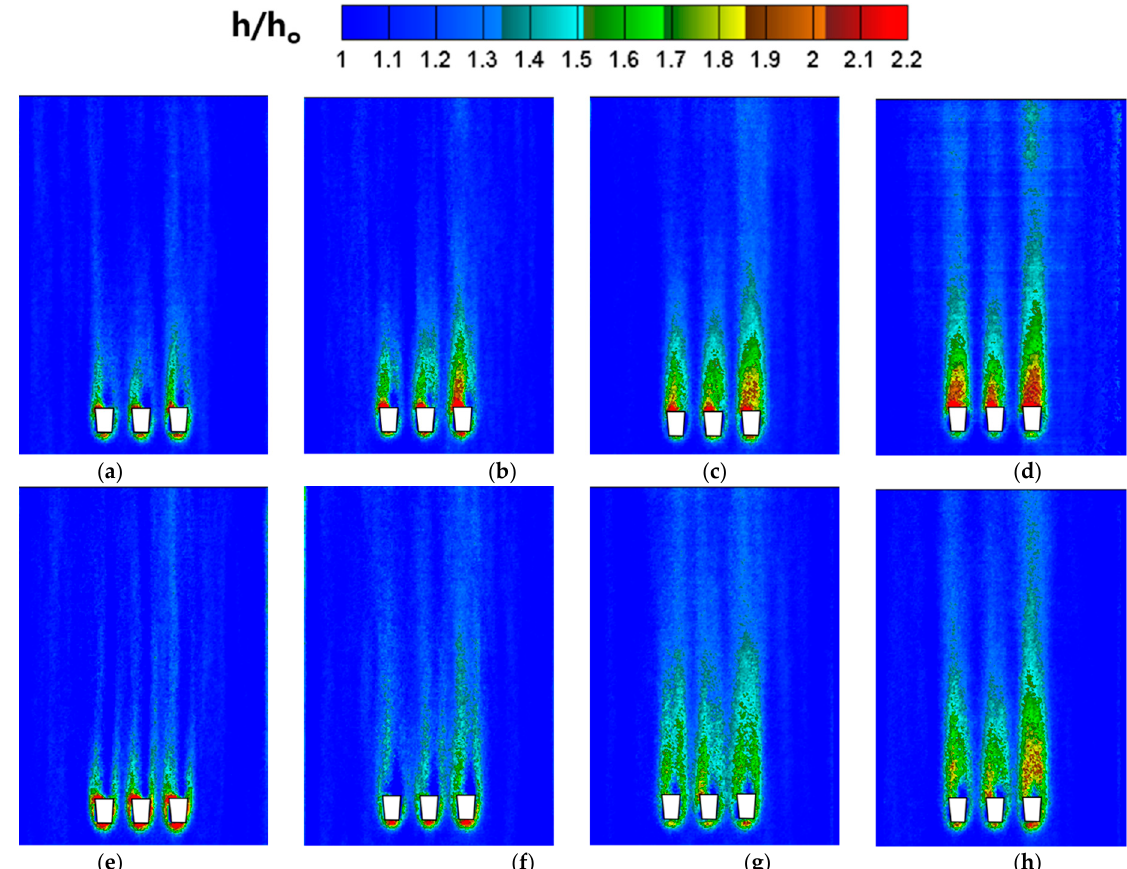
Figure 16. Distributions of h/h o for different density ratios: ( a ) DR = 1.0, M = 1.0; ( b ) DR = 1.5, M = 1.0 ( c ) DR = 2.0, M = 1.0; ( d ) DR = 2.5, M = 1.0; ( e ) DR = 1.0, M = 2.0; ( f ) DR = 1.5, M = 2.0; ( g ) DR = 2.0, M = 2.0; and ( h ) DR = 2.5, M = 2.0.